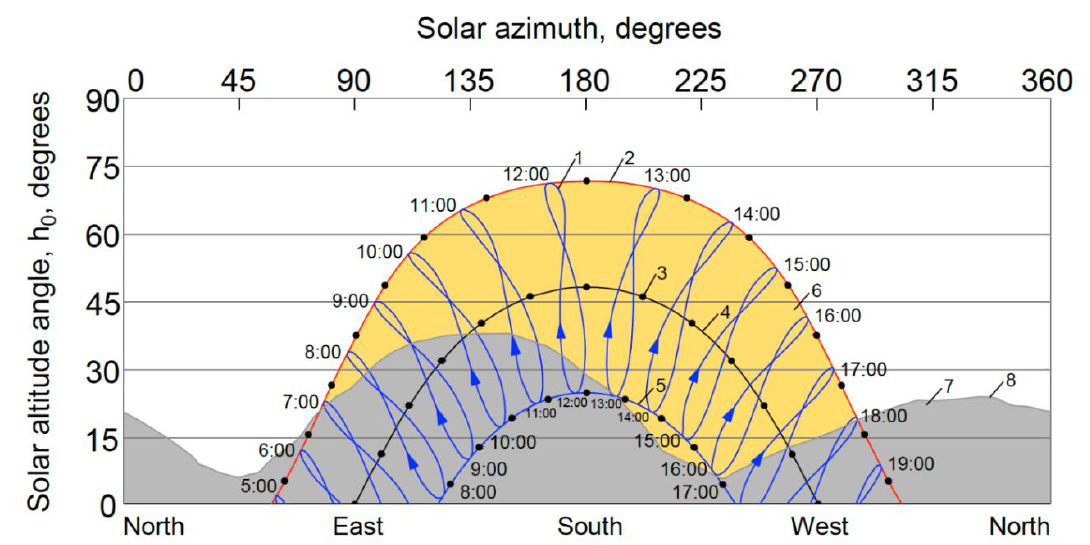
Figure 5. Graph of changes in angular altitude ( h 0 ) and the azimuth of the sun, where: 1—local time in the construction area (time zone Tashkent, Uzbekistan, UTC+05:00); 2—movement of the sun at the summer solstice 21.07. 2021; 3—true solar time; 4—sun movement at the spring/autumn equinox; 5—sun movement at the winter solstice 21.12.2021; 6—zone of active solar exposure; 7—shading caused by surrounding terrain; 8—contour of the surrounding terrain at the construction